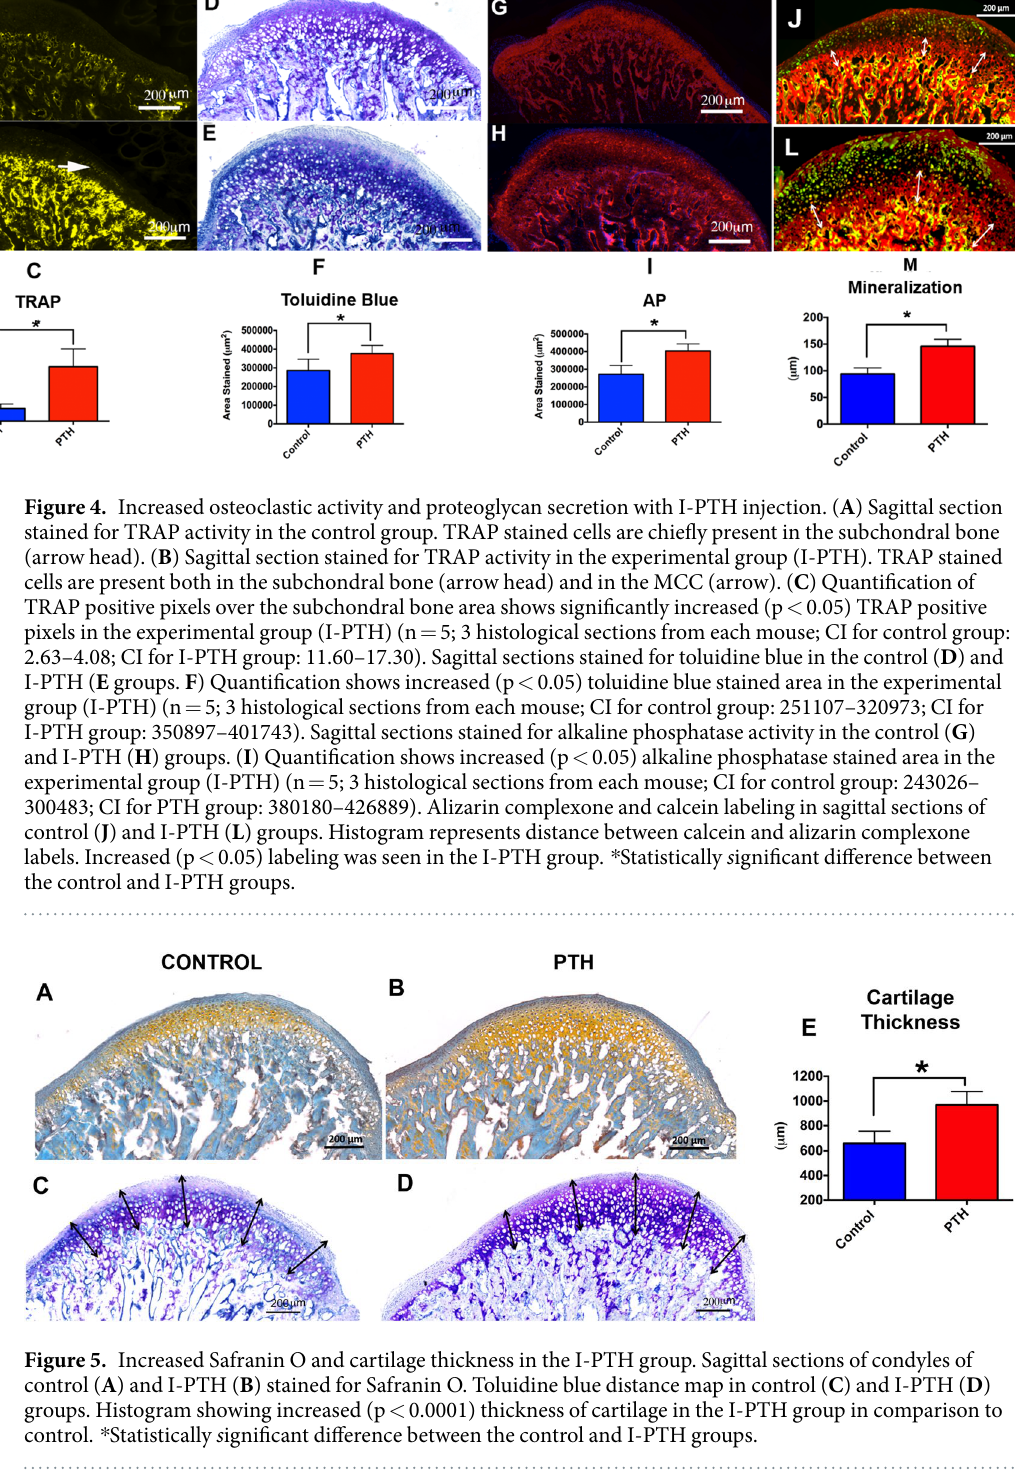
I-PTH leads to increased expression of pSMAD158 and VEGF expression. Our immunohisto- chemistry showed increased expression of pSMAD158 in the MCC and subchondral bone of the experimental group, relative to the control group (Fig. 6A and B). Similarly, there was also an increase in the expression of VEGF in the not only in the MCC but also in the subchondral bone of the I-PTH administered group (Fig. 6D and E).